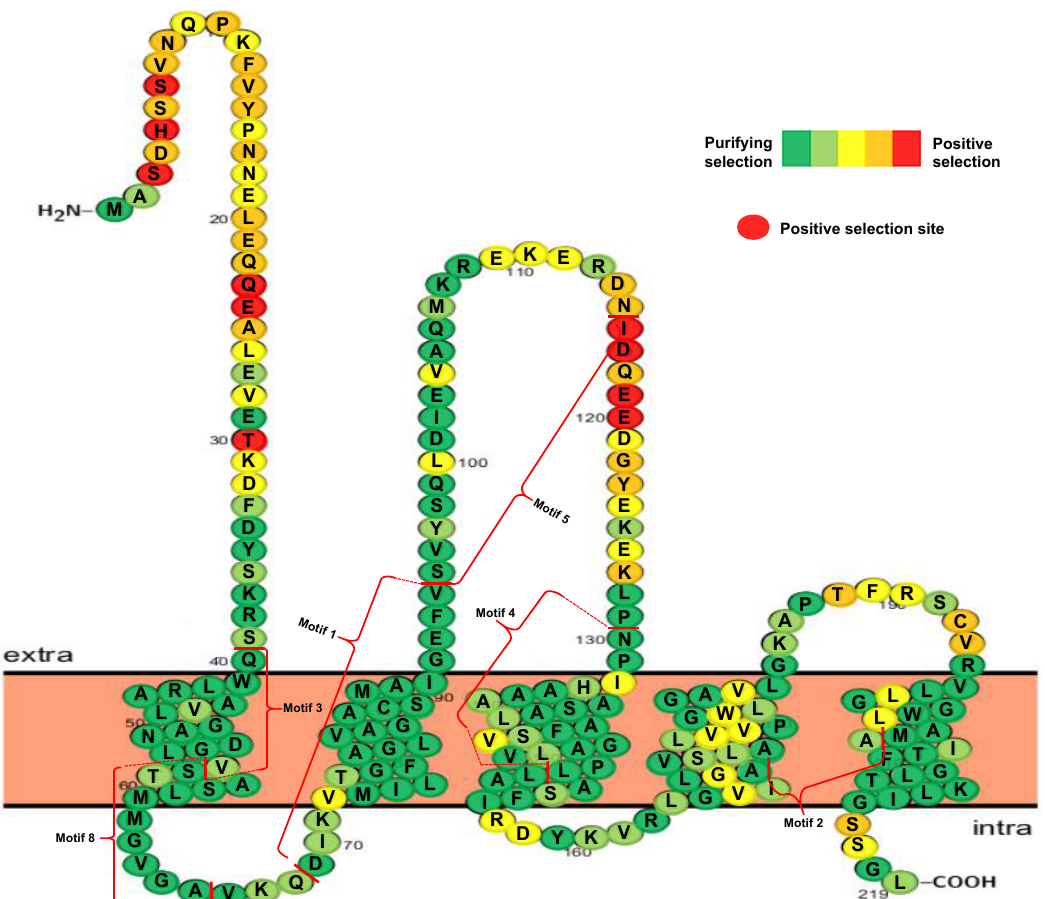
Figure 3. Distribution of positive selection sites of VIT members in Group I predicted by M8